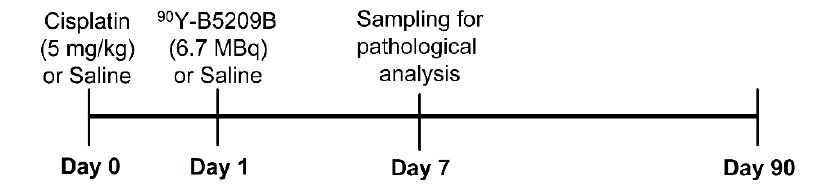
Figure 6. Therapeutic study experimental schedule.